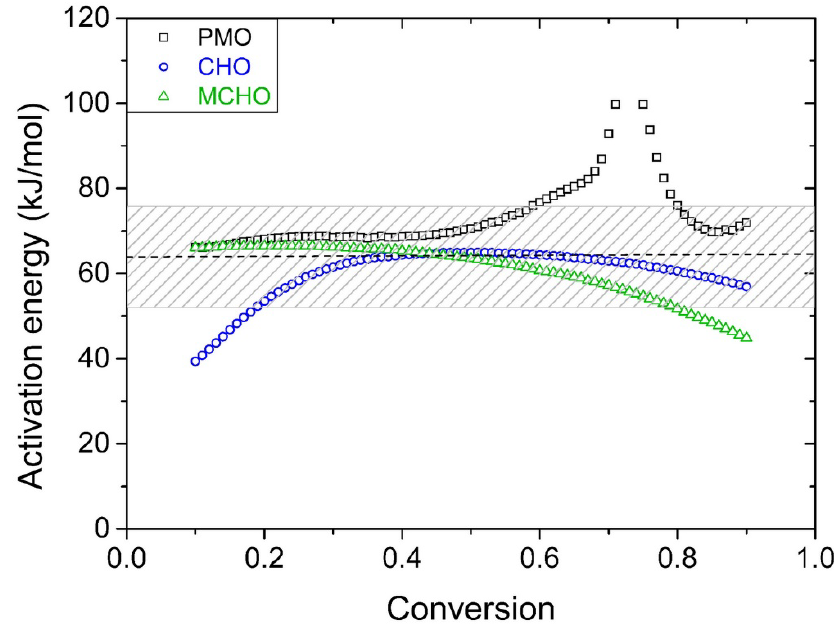
Figure 5. Activation energy as a function of the conversion between HMPA and PMO, CHO and MCHO, as calculated with VA method.